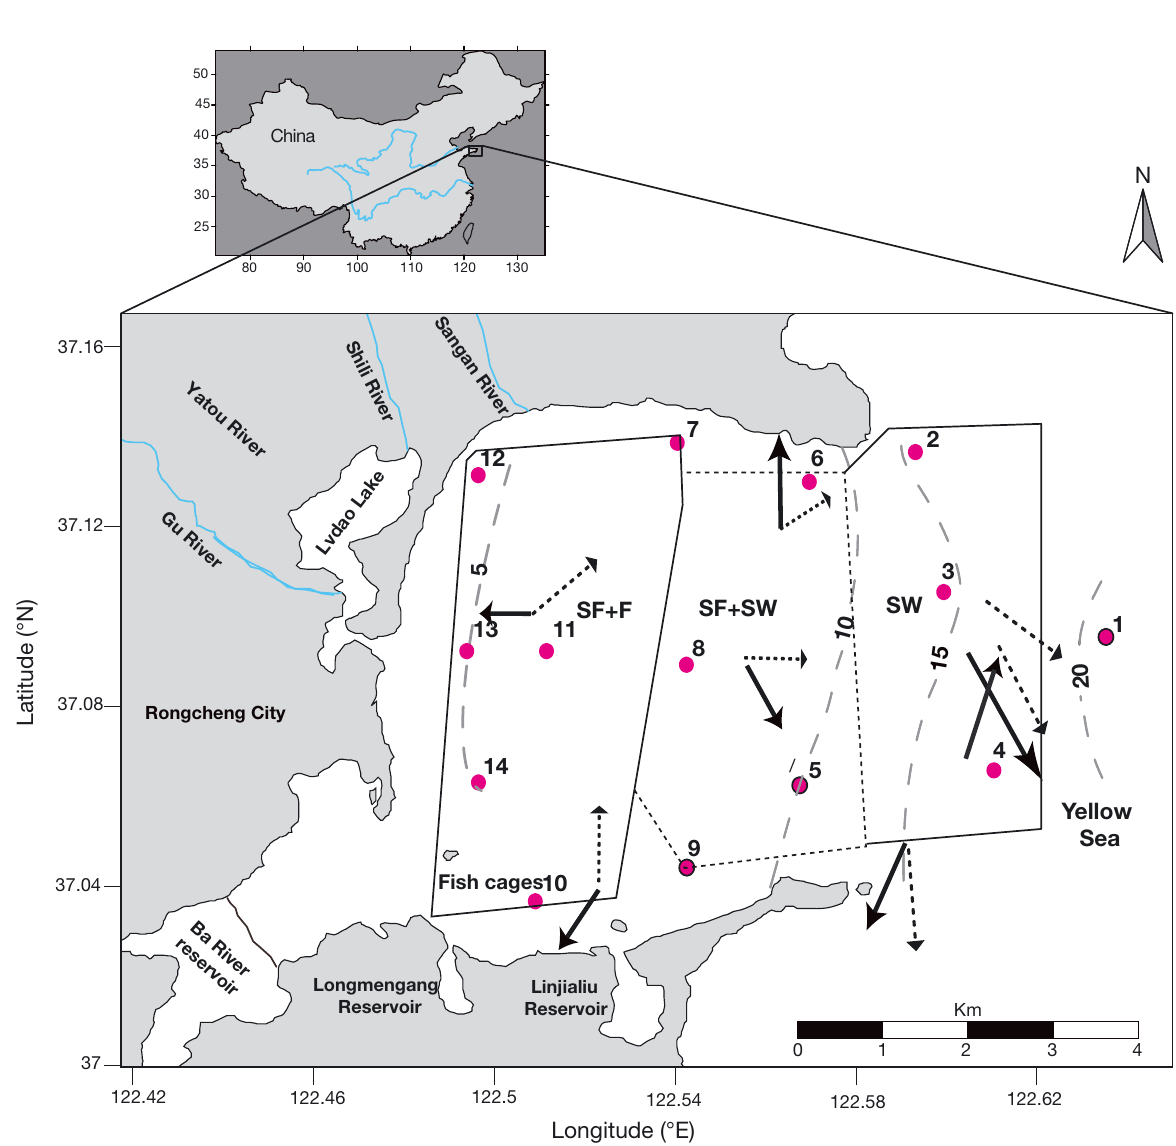
Fig. 1. Map of Sanggou Bay, showing culture areas (polygons with solid and dotted lines) and 14 stations (red dots) of cruises in August 2011 (wet season, summer) and January 2012 (dry season, winter). Culture areas include combined culture of shellfish and fish (SF+F), shellfish and seaweed (SF+SW) and monoculture of seaweed (SW). Solid arrows denote surface water current and dashed arrows bottom flow (source: Ferreira et al. 2007). Grey dashed lines denote isobaths